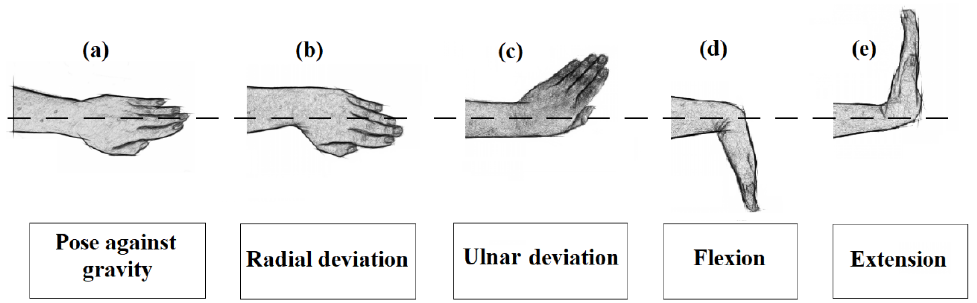
Figure 3. ( a ) hand in neutral position; ( b ) radial deviation; ( c ) ulnar deviation; ( d ) flexion and ( e ) extension.